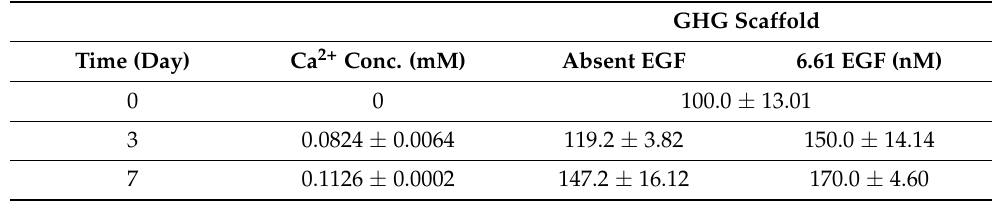
Table 1. Comparison of calcium ion release and EGF concentration in the GHG scaffold with the breast cancer cells numbers 1,2